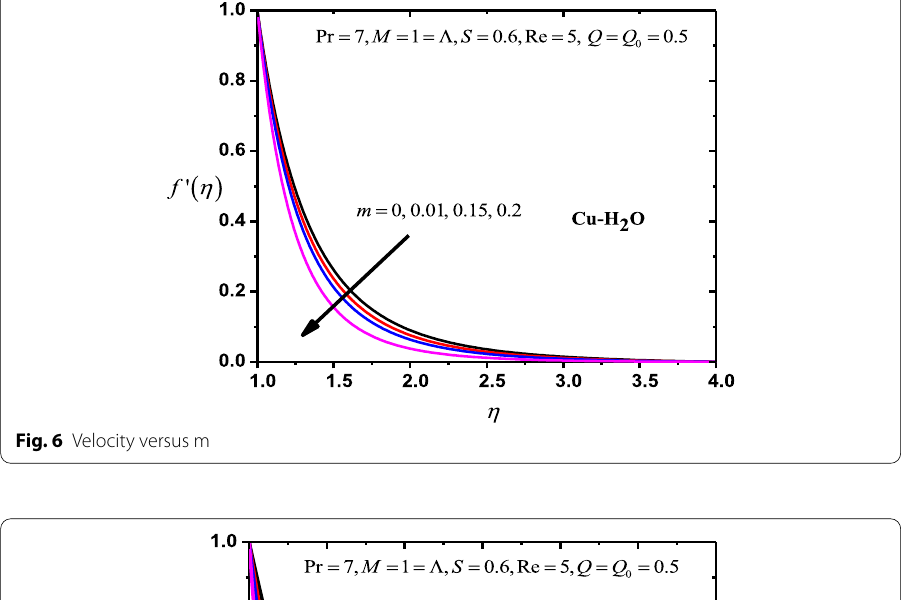
Fig. 6 Velocity versus m